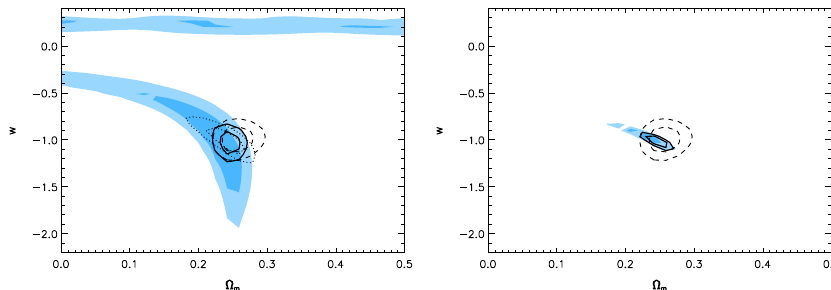
Fig. 55 Forecasted 68 and 95% likelihood contours for SN (filled blue), H(z) (dashed line transparent) and combined SN+H(z) (solid line transparent), assuming Euclid BAO is accompanied by a SNAP-like (or Dark Energy Task Force stage IV) supernova sample. We show constraints on the Ω m − w plane, having marginalised over all other parameters in the context of flat wCDM models. On the left, we have allowed a coupling between photons and a putative dark energy scalar at the level allowed by current data, while on the right we have set this coupling to zero. The dotted contours on the left show SN contours assuming constraints on this coupling can be improved by an order of magnitude. Note how the joint contours become dominated by the SN data if this coupling is strongly